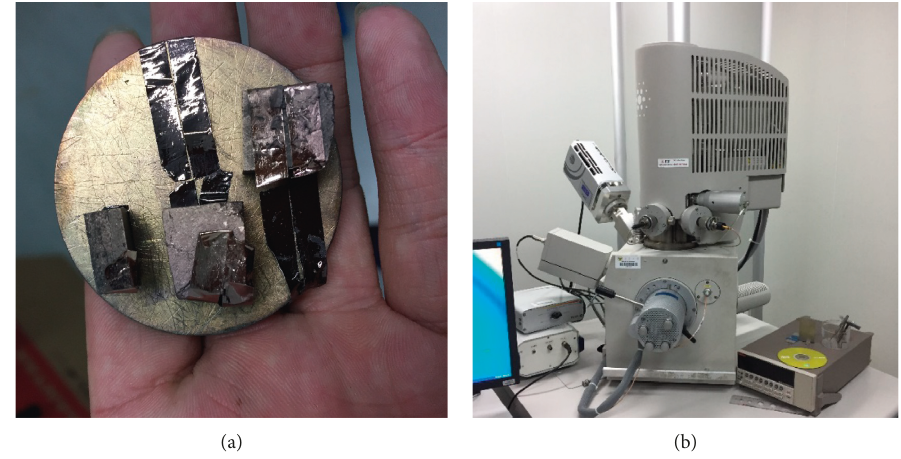
Figure 3: SEM: (a) specimen after gold plating; (b) equipment.